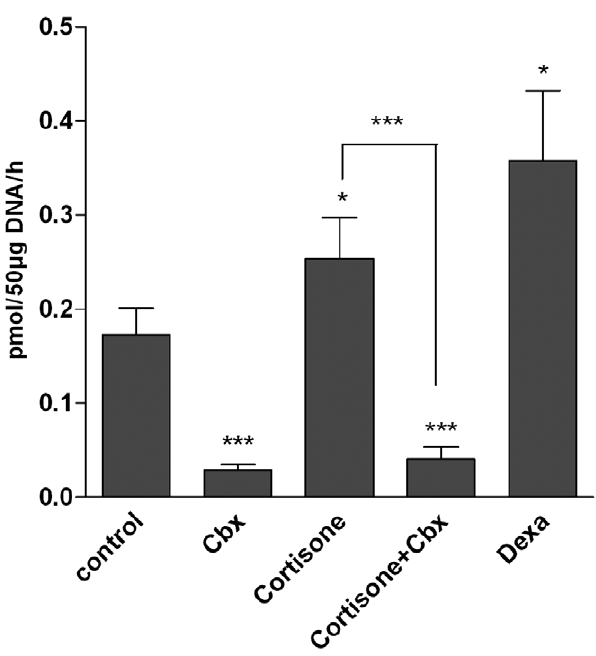
Figure 2. Effects of cortisone, dexamethasone (dexa) and inhibition of 11beta-HSD1 by carbenoxolone (Cbx) on 11be- ta-HSD1 activity in C2C12. Mean 6 SEM of at least three experiments are shown. * p , 0.05, ** p , 0.01, *** p , 0.0001.